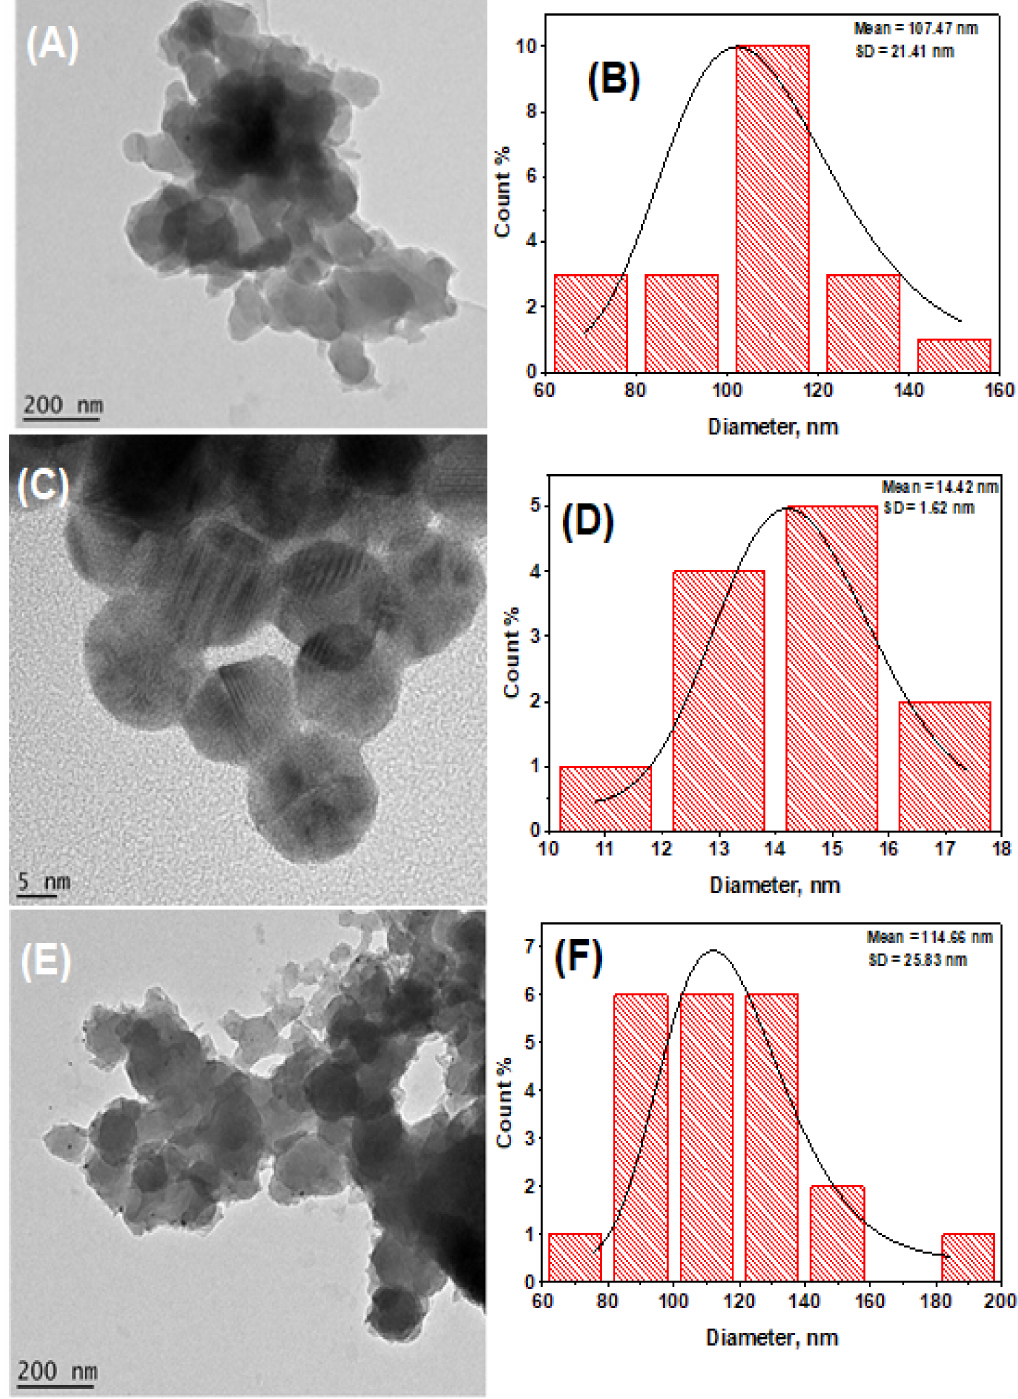
Figure 4. HR-TEM micrographs of ( A ) PPy, ( C ) TGA-OsTe 2 QD and ( E ) TGA-OsTe 2 QD-PPy at 200 nm and 5 nm scale view. ( B , D , F ) show statistical size distribution histograms of PPy, TGA-OsTe 2 QD, and TGA-OsTe 2 QD-PPy,